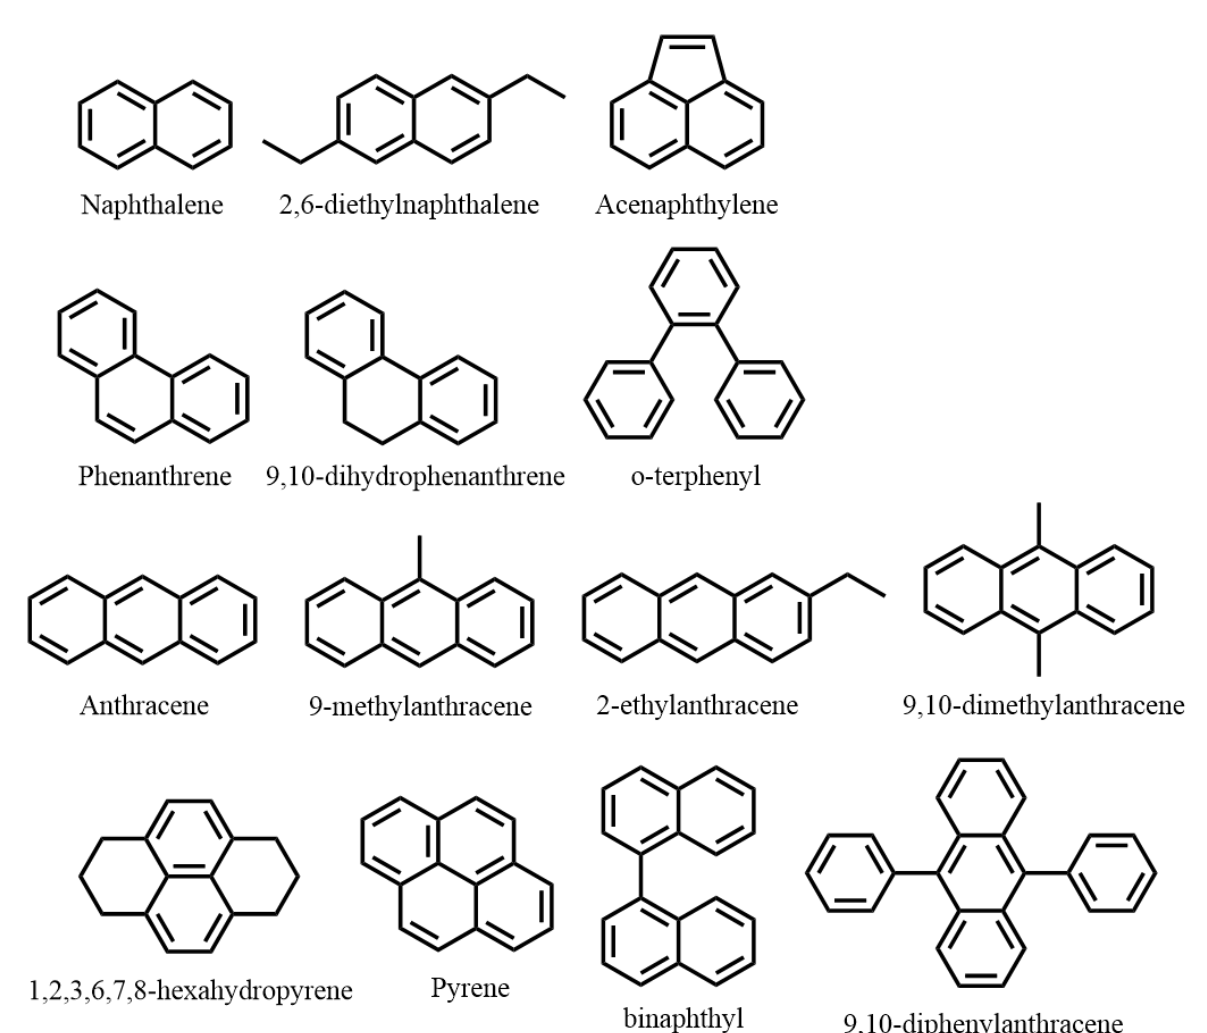
Figure 5. Aromatic model compound molecules that elute in the Aro-2 fraction.